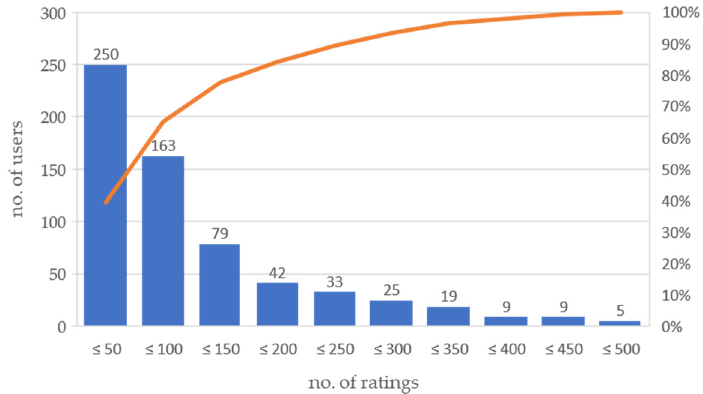
Figure 20. User distribution based on the number of ratings.